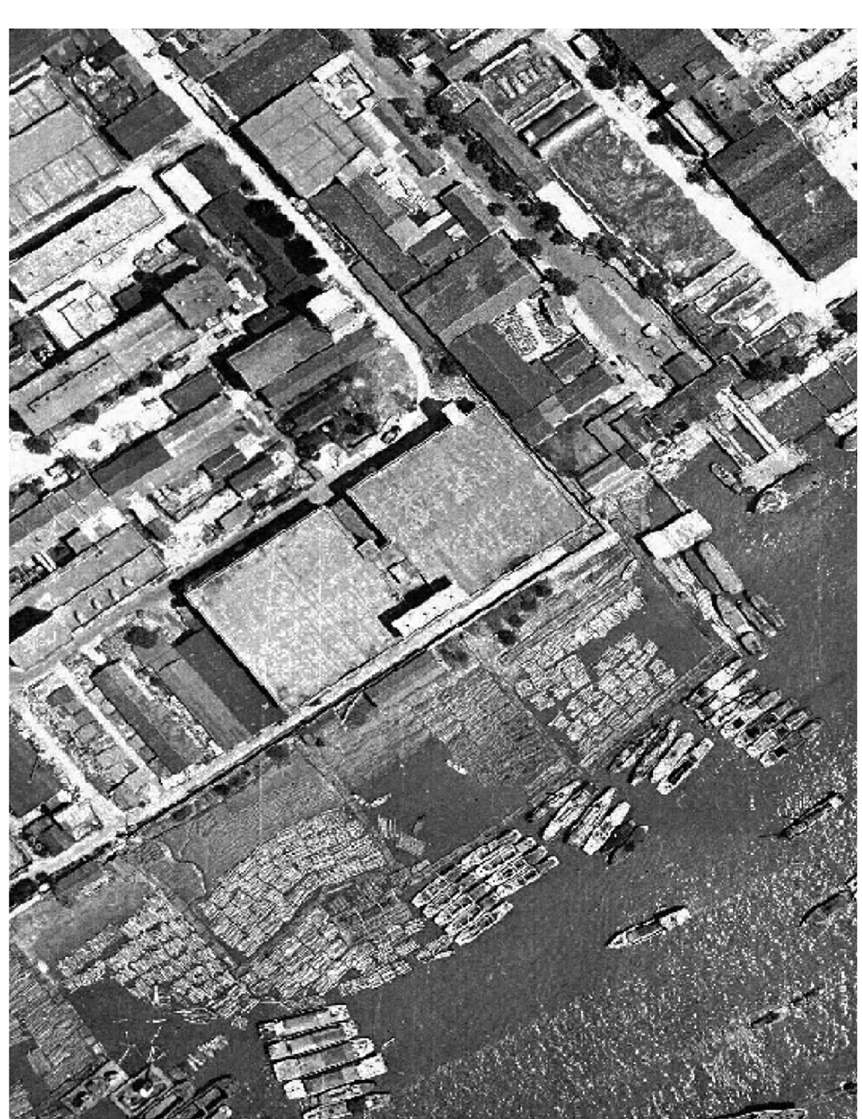
Fig. 4 Aerial view of the historical Yong ’ an Warehouse in 1979 (Source: